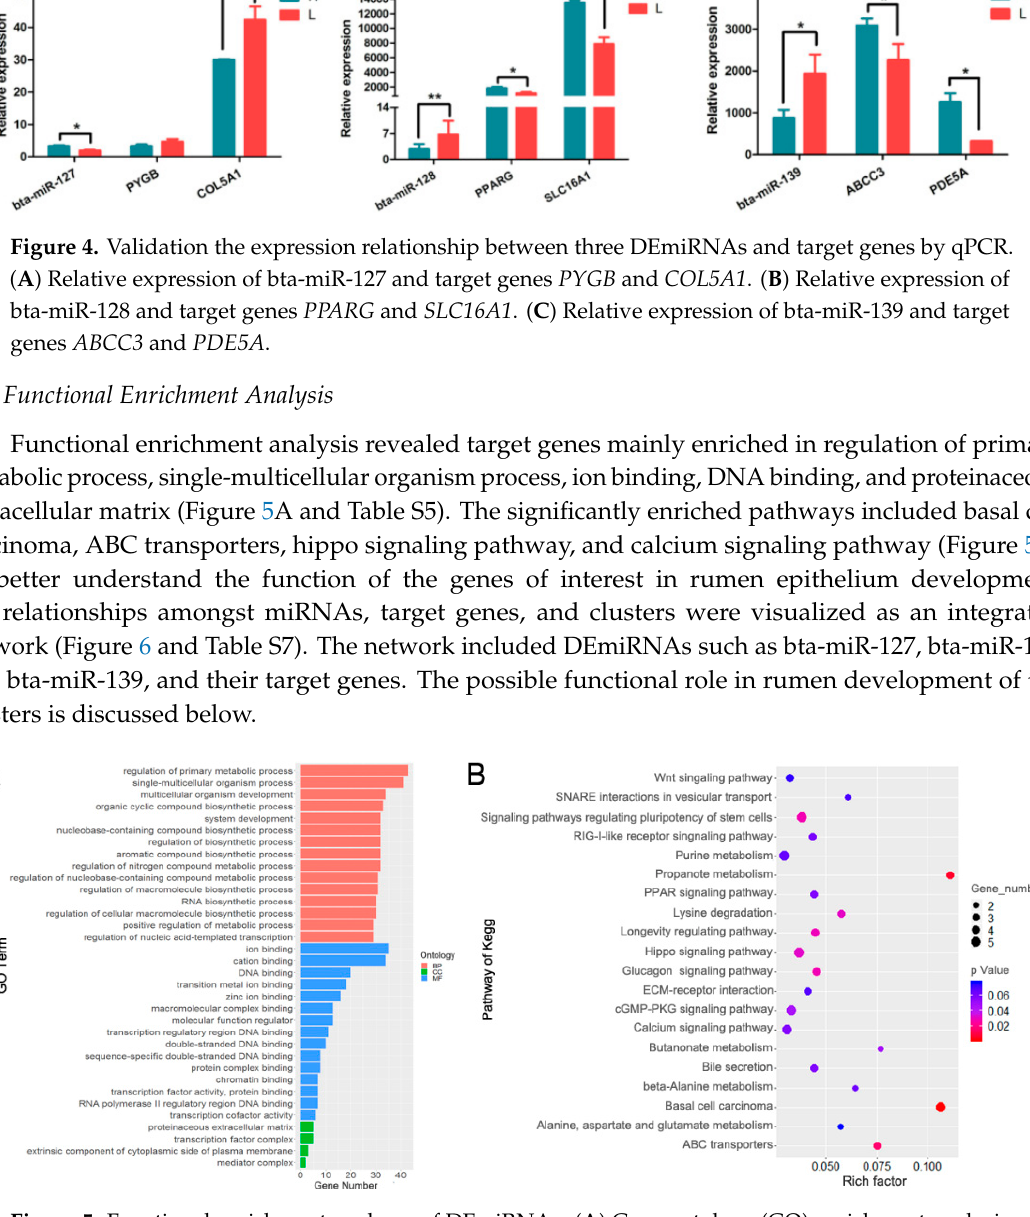
Figure 5. Functional enrichment analyses of DEmiRNAs. ( A ) Gene ontology (GO) enrichment analysis of target genes. Biological process (BP), cellular component (CC), molecular function (MF). ( B ) Kyoto encyclopedia of genes and genomes (KEGG) pathways enrichment analysis of target genes.